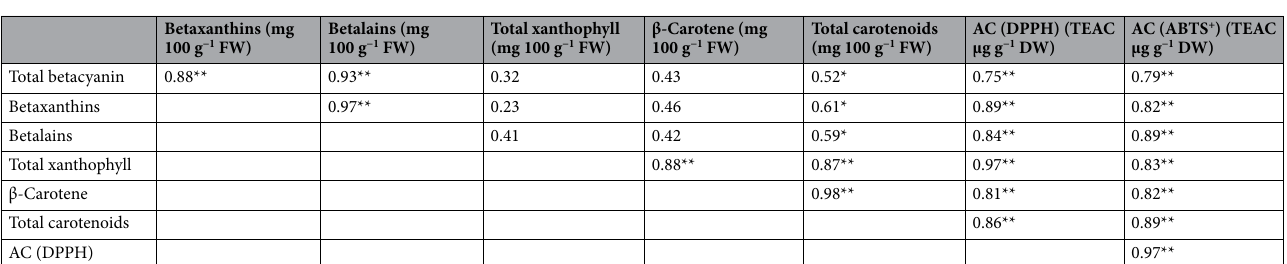
Table 3. The correlation coefficient for total betacyanin, major carotenoids components, antioxidant constituents, and antioxidant capacity in four selected A. gangeticus leafy vegetables. AC (DPPH) antioxidant capacity (DPPH), AC (ABTS + ) Antioxidant capacity (ABTS + ). *Significant at 5% level. **Significant at 1% level, (n =